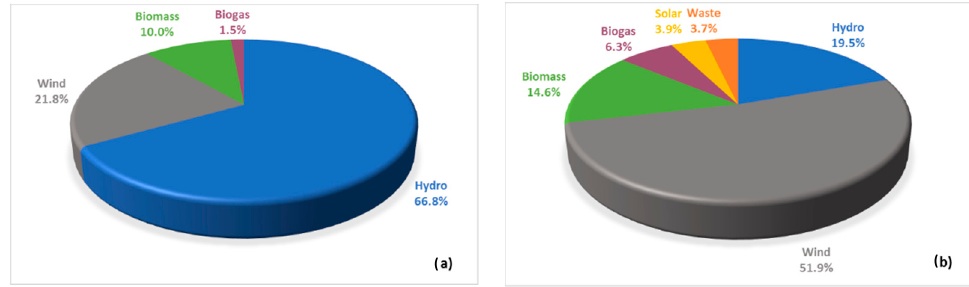
Figure 4. The distribution of electricity generation from di ff erent renewable energy sources in Lithuania: ( a ) 2008 and ( b ) 2018 [33].